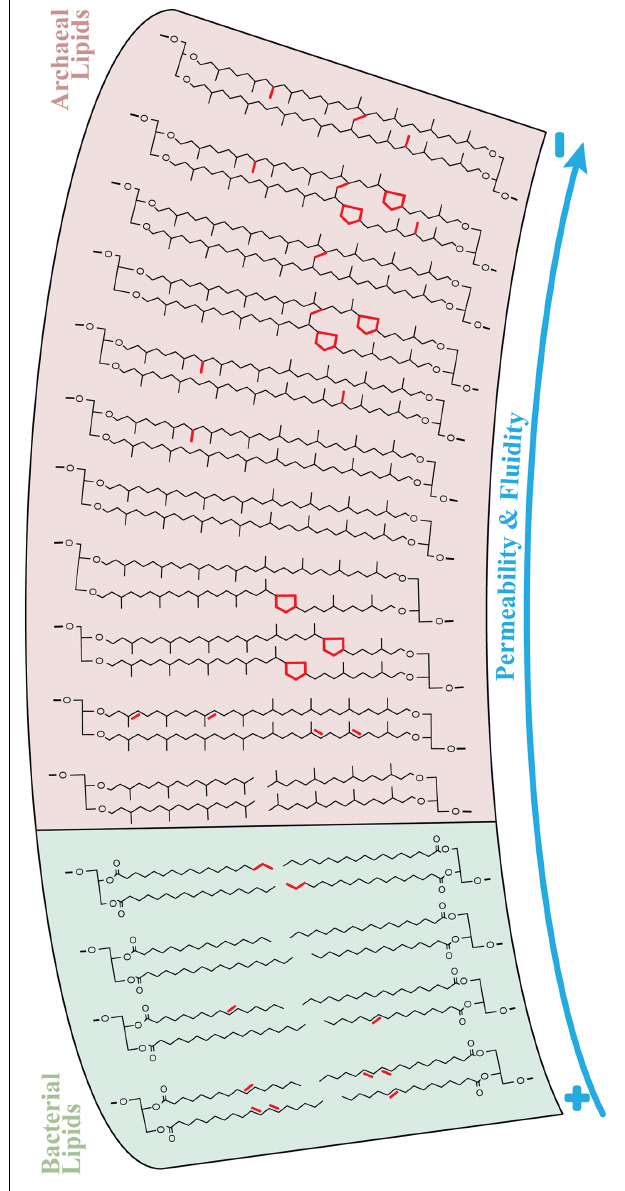
FIGURE 6 | Lipid chemical structures determining ion permeability (e.g., proton and sodium) and fluidity of archaeal and bacterial membranes in sediments of Milos. The arrows indicate a continuum trend from high (+) to low (–) membrane permeability and fluidity. The essential structural distinction between archaeal and bacterial lipid membranes are the ether-linked isoprenoids in the former and typical ester-linked fatty acids in the latter. The permeability and fluidity properties of bacterial membranes were mainly regulated by the degree of unsaturation (i.e., number of double bonds) and chain length of fatty acids (highlighted in red), as shown in Figure 5 . Apart from the transition diether to tetraether, i.e., bilayer to monolayer membranes, archaea featured several modifications in tetraethers that are suggested to influence the permeability and fluidity properties of their membranes ( Figure 5 ). These features (in red) include unsaturation, cyclization and methylation of biphytane(s) and covalent bonds between isoprenoidal chains